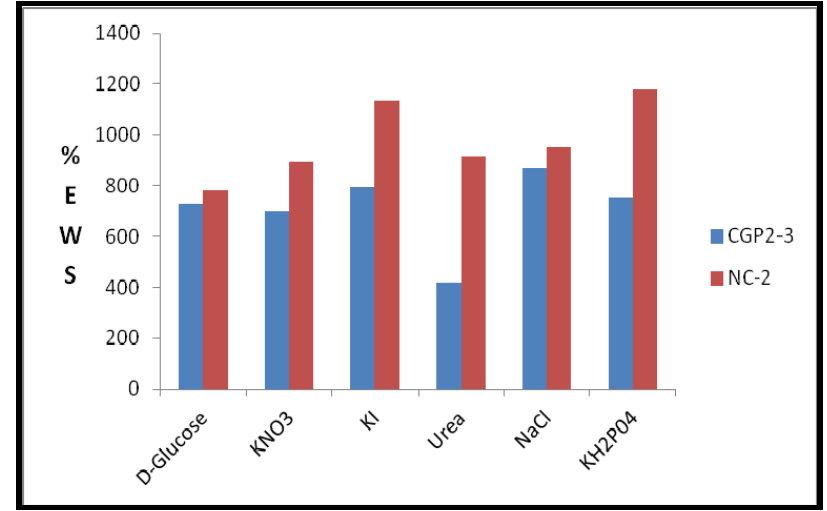
Figure 12. Effect of physiological solutions on % EWS of CGP2 ‐ 3 and NC ‐ 2 hydrogels. Figure 12. E ff ect of physiological solutions on % EWS of CGP2-3 and NC-2